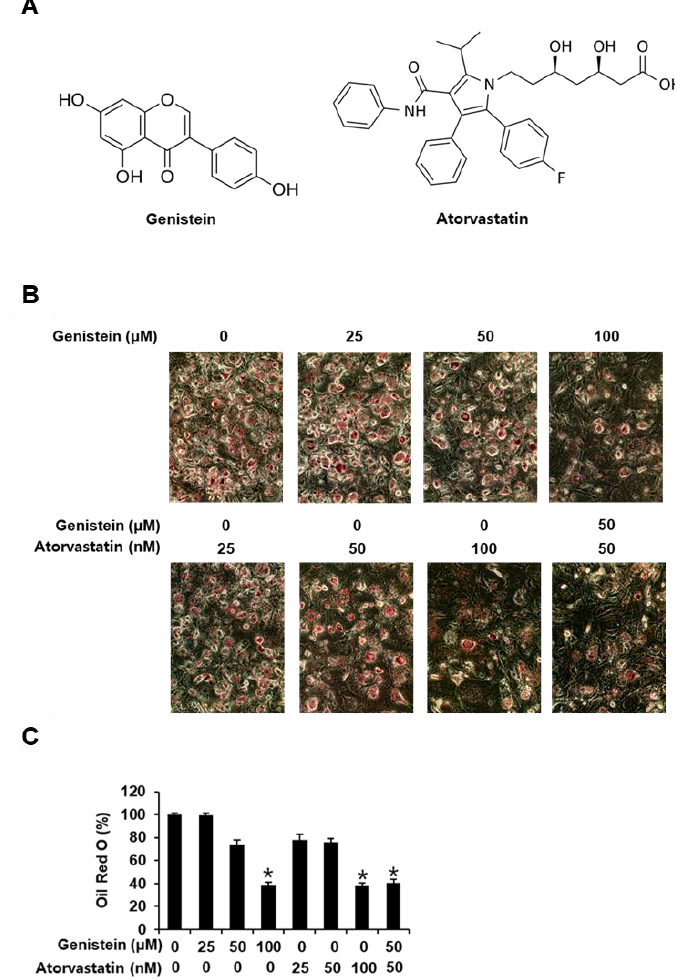
Figure 1. Inhibitory effects of genistein and atorvastatin on adipogenesis in 3T3L-1 preadipocytes. ( A ) Chemical structure of genistein and atorvastatin. ( B ) Images of the Oil Red O staining of differen- tiated 3T3L-1 cells photographed under an inverted microscope with 20X magnification on day 8 after treatment with genistein and/or atorvastatin. ( C ) Quantification of Oil Red O staining expressed as the percentage of the untreated control (n = 3 independent experiments, * p < 0.05, Kruskal–Wallis nonparametric test). Data are the mean ± SEM.